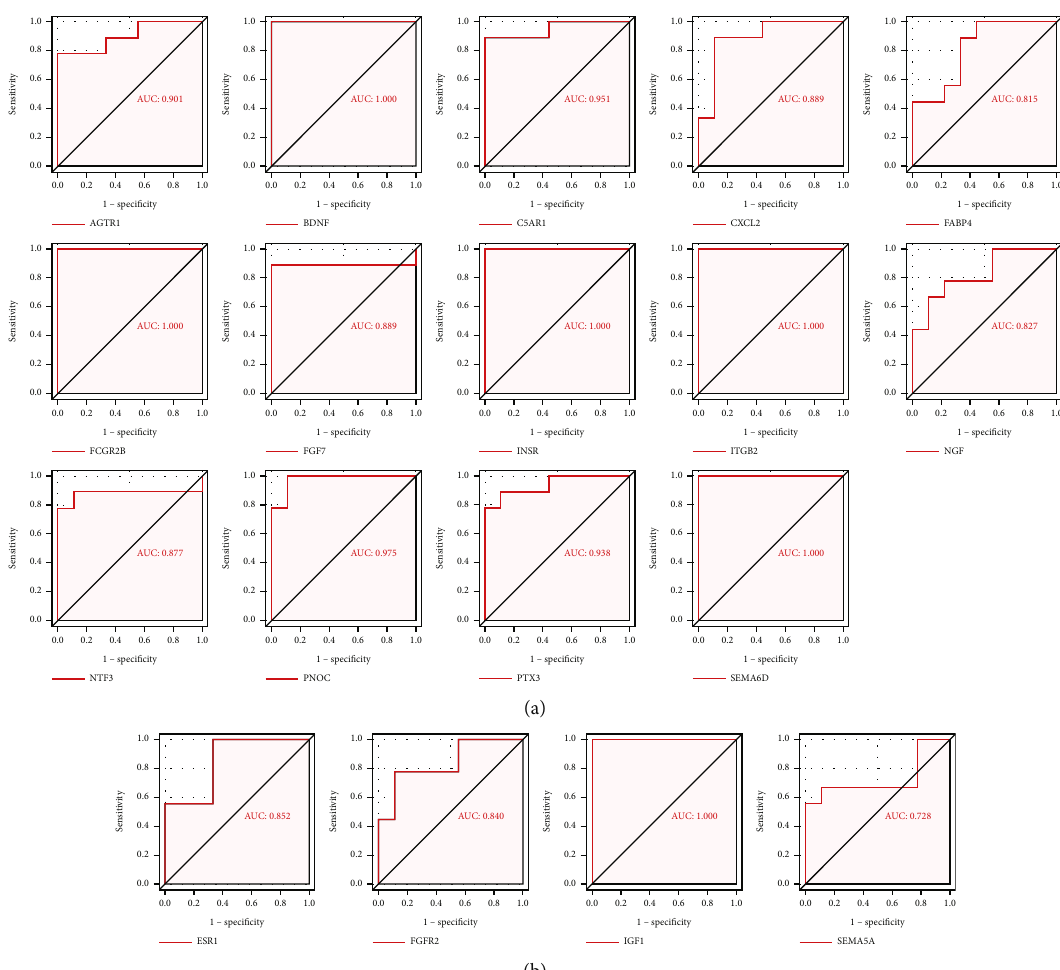
Figure 10: The ROC analysis of the hub IRGs predicting the infertility of endometriosis. (a) The ROC analysis of upregulated DEIRGs predicting infertility of endometriosis in GSE120103. (b) The ROC analysis of downregulated DEIRGs predicting infertility of endometriosis in